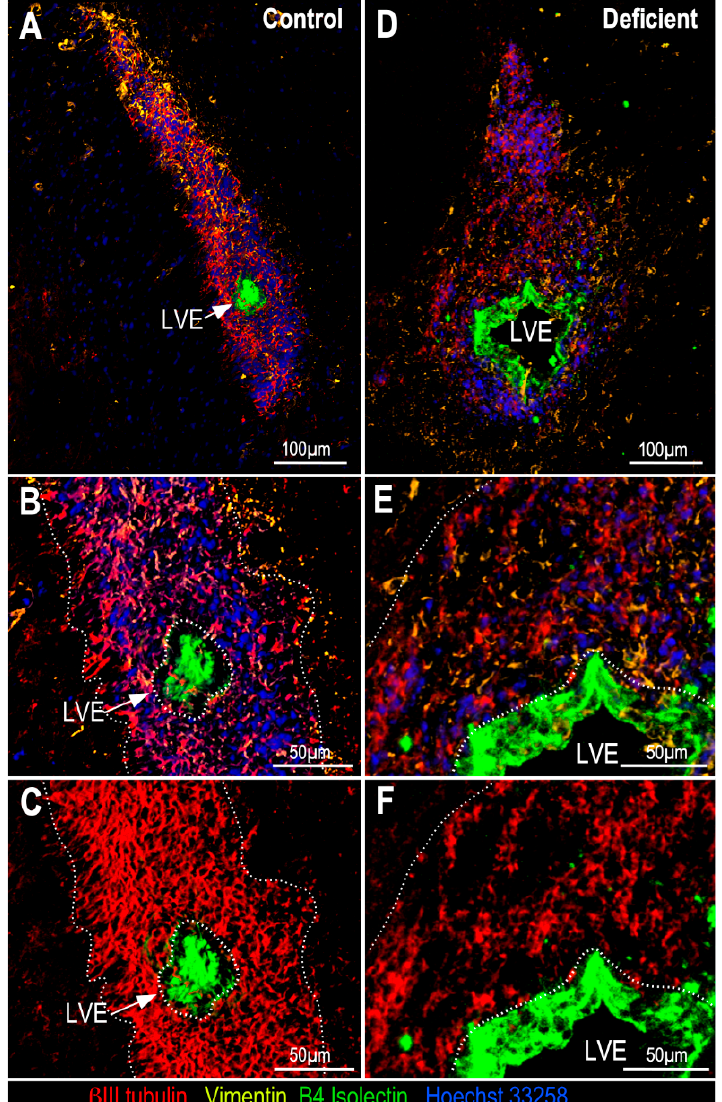
Figure 5. Multi-labeling analysis of neuronal and glial distribution in the LVE of adult vitamin-C- deficient guinea pigs. Z-stacks projections, 3D reconstruction and tile scanning, using multiple markers: anti- β III tubulin (1:1000, red), anti-vimentin (1:100, yellow), B4 isolectin (1:10, green) and Hoechst 33258 (1:1000, blue). ( A ) Distribution of glial and neuronal cells in the LVE of control guinea pig brain. ( B ) Higher magnification of the LVE in image A. ( C ) Same image as in panel B, without blue (nuclei) and yellow (glial cells) channels. ( D ) Glial and neuronal distribution in the LVE of the brain of guinea pigs with 21 days of vitamin C deficiency. ( E ) Higher magnification of the LVE in image D. ( F ) Same image as in panel E, without blue (nuclei) and yellow (glial cells) channels. Here, the density of neuroblasts (red) was much lower than in the control ( C , dotted lines); however, the number of glial cells (yellow) was similar. LVE: lateral ventricle extension.